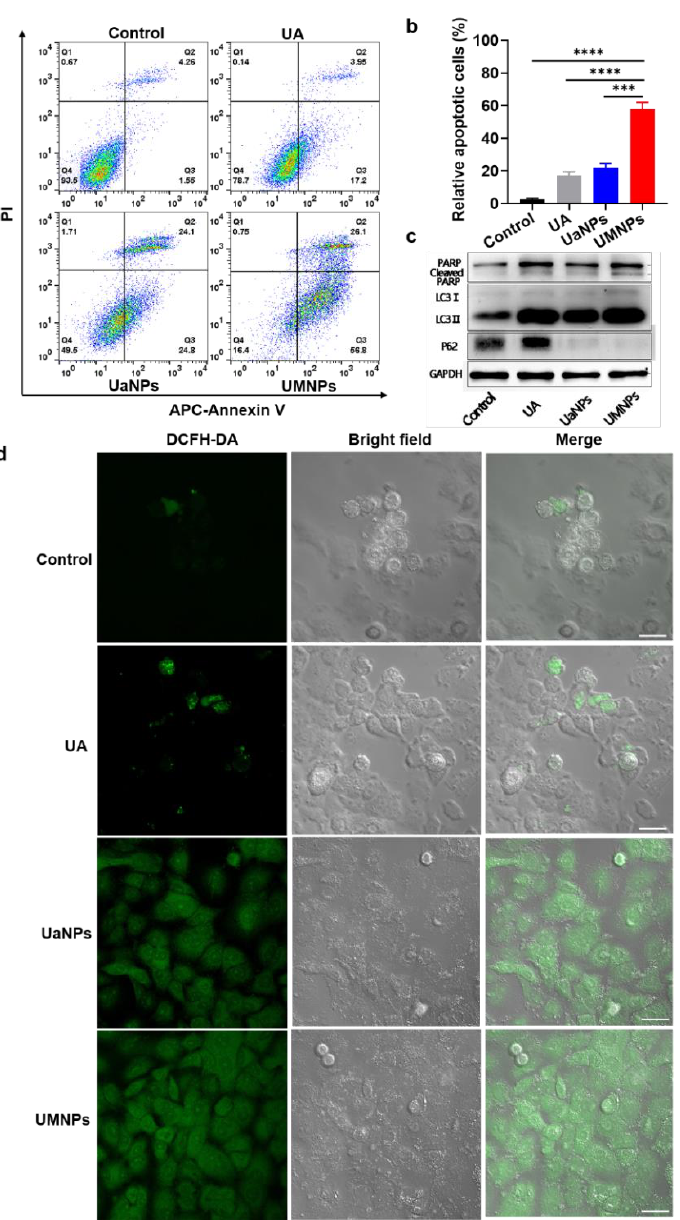
Figure 4. UA, UaNPs, and UMNPs induce apoptotic and autophagic cell death in NSCLC cells. ( a , b ) Flow cytometry analysis to detect the apoptotic effect of free UA, UaNPs, and UMNPs in A549 cells for 48 h. ( c ) Western blotting was used to detect expression of apoptosis- and autophagy-related proteins in A549 cells treated with UA, UaNPs, and UMNPs for 48 h. ( d ) Alteration of intracellular reactive oxygen species levels by UMNP treatment. Control for A549 cells with DCFH-DA treatment. Scale bar = 20 µ m. Differences were considered significant when *** p < 0.001 or **** p < 0.0001,